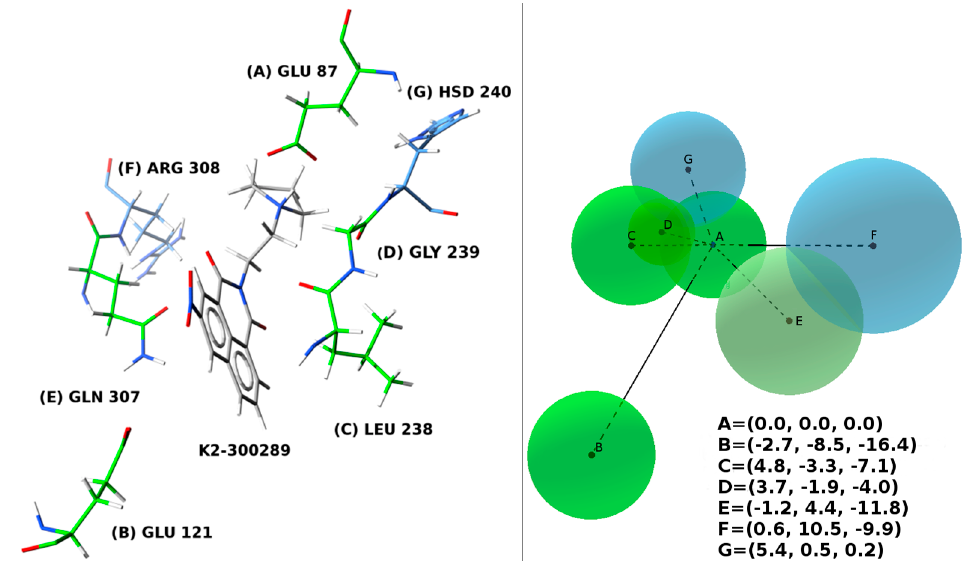
Figure 3. Common contacts across the training set. A . Compound K2-300289 and the amino acids forming the conserved contacts; B . Pharmacophore. The spheres represent the amino acids forming contacts with the ligands and are centered at their centers of mass (COM). The sphere radius is equal to the maximum distance between the amino acid COM and one of its atoms. The attractive AAs were colored in green, the repulsive in blue. A = (0, 0, 0); RA = 3.5; B = ( − 2.7, − 8.5, − 16.4); RB = 3.7; C = (4.8, − 3.3, − 7.1); RC = 3.6; D = (3.7, − 1.9, − 4.0); RD = 2.1; E = ( − 1.2, 4.4, − 11.8); RE = 4.3, F = (0.6, 10.5, − 9.9), RF = 5.1, G = (5.4, 0.5, 0.2), RG = 3.7. All coordinates are given in Ångstroms.